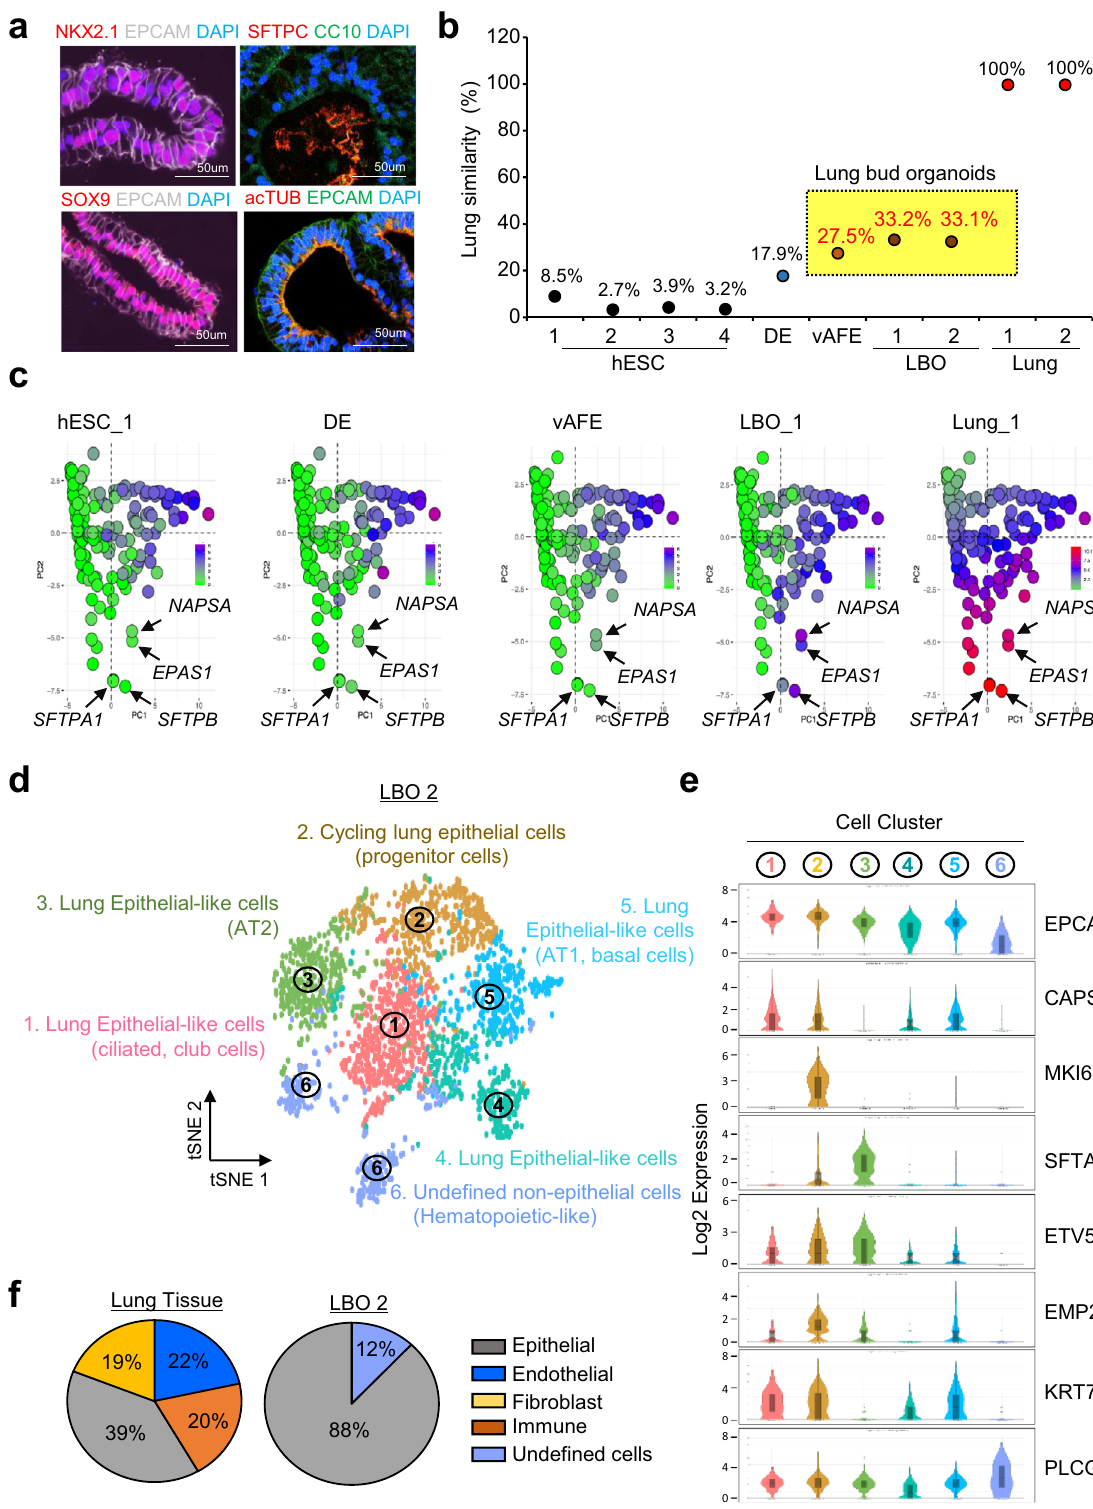
To further verify the lung-speci fi c similarity of LBO in the ciliated cells, basal cells, and a small number of club cells and context of cellular diversity, we performed single-cell RNA- mucose cells) and unde fi ned nonepithelial cells (expressing some sequencing (scRNA-seq) analysis with the same LBO-2 batch that hematopoietic-related genes but not expressing the canonical showed 33.1% similarity in LuGEP analysis (Fig. 3b). Cell immune cell marker PTPRC) (Fig. 3d, e and Supplementary clustering and cell-type annotation with cell-type-speci fi c mar- Fig. S2). According to a recently reported scRNA-seq study on kers revealed that LBO-2 consisted of seven lung epithelial-like human lung tissue 27 , the human lung is composed of 39% epithelial cells, 22% endothelial cells, 20% immune cells, and 19% cells (lung epithelial progenitor cells, alveolar type 2 and 1 cells, NATURE COMMUNICATIONS| (2021) 12:4492